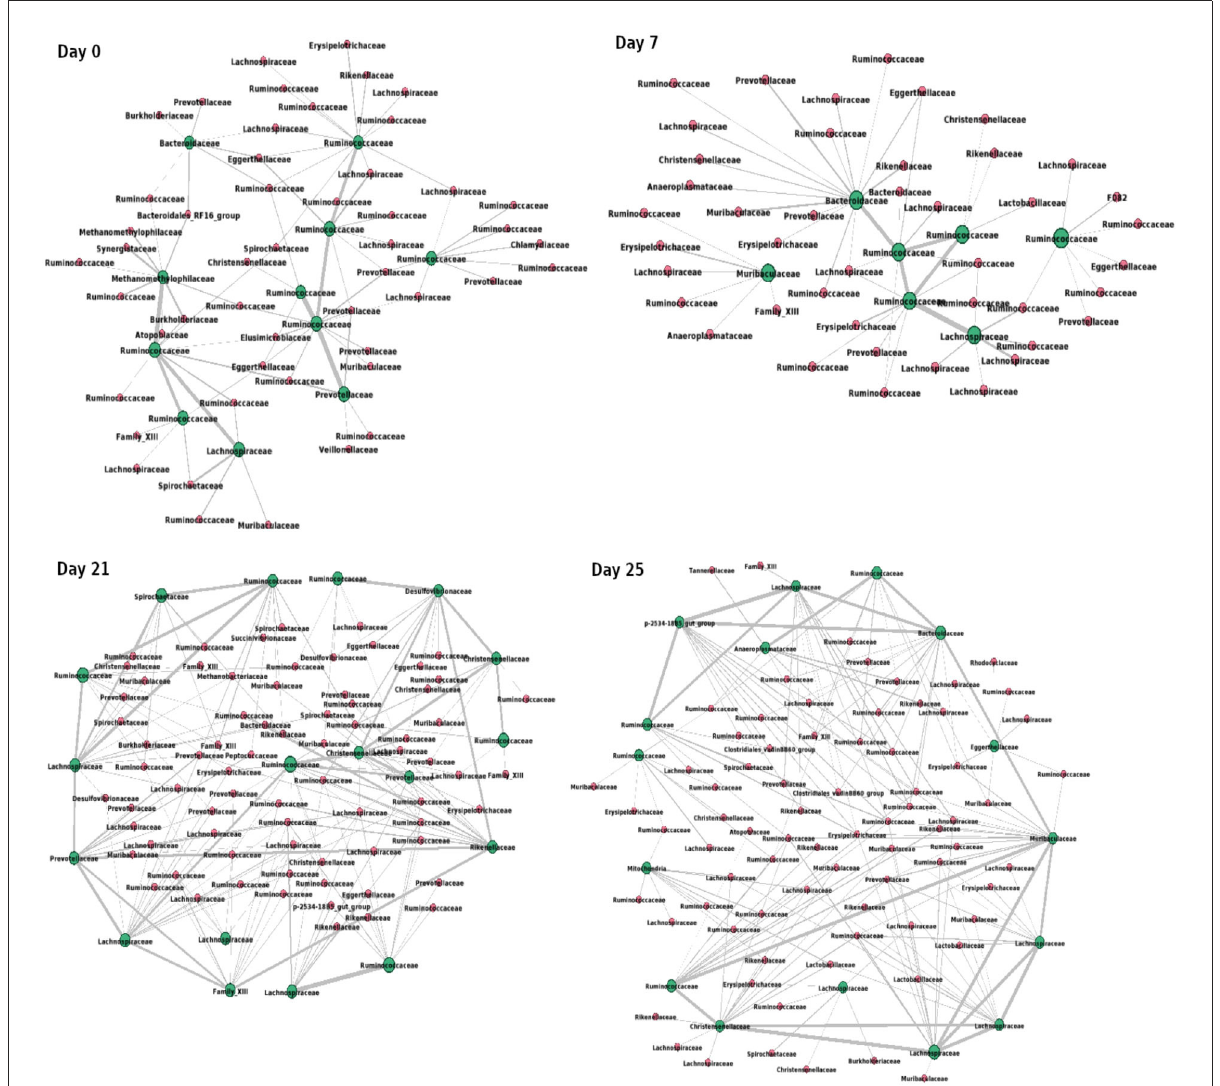
FIGURE9 Network consisting of driver ASVs and their interaction partners at each of the time-points. Green nodes represent the names of families of corresponding driver ASVs. Thickness of edges is proportional to the corresponding correlation coefficient value. The network is drawn using Gephi tool (Bastian et al.,